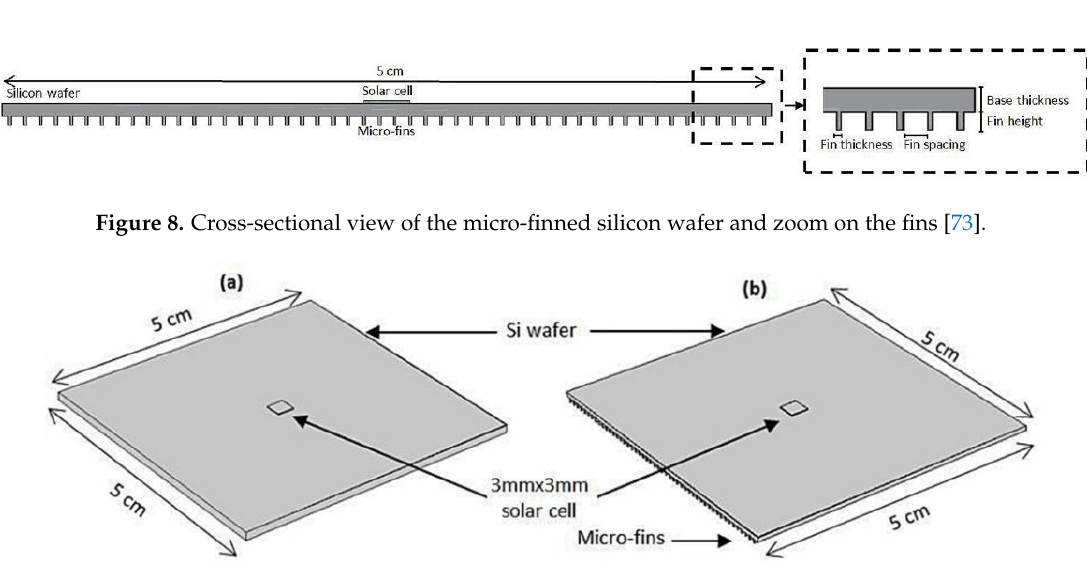
Figure 9. The geometries of ( a ) unfinned silicon wafer; ( b ) micro-finned silicon wafer [73].